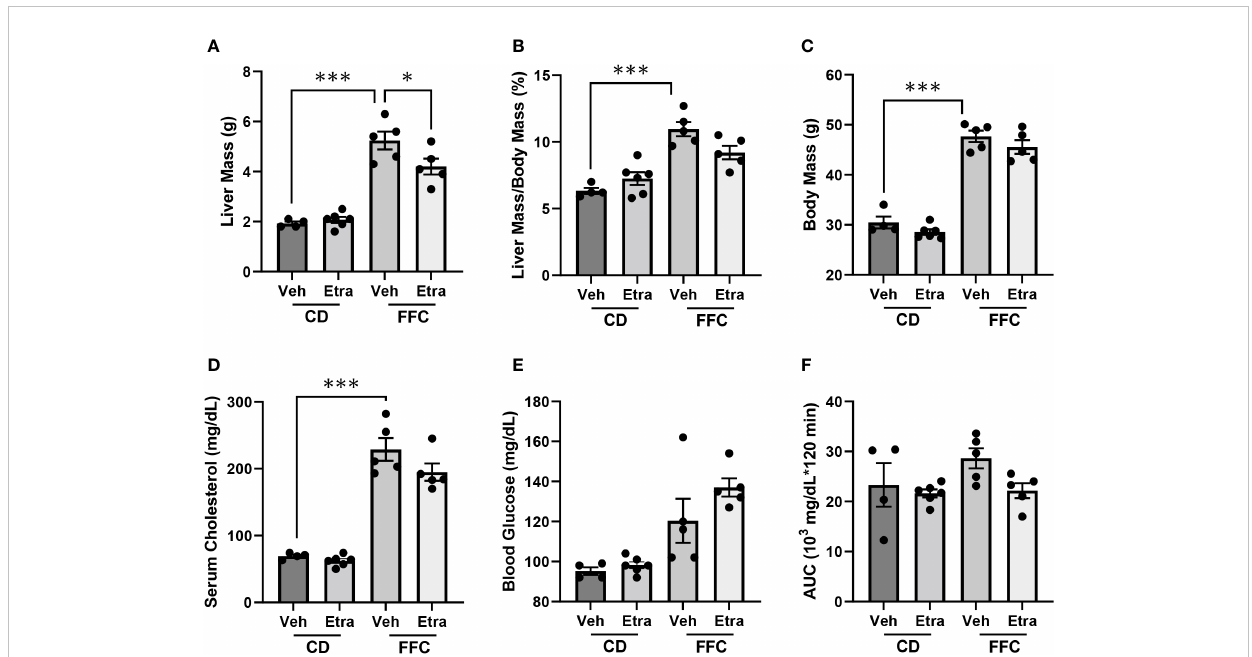
FIGURE 2 Metabolic characterization of CD and FFC-fed mice with Etrasimod treatment. (A) Liver mass, (B) liver to body mass ratio, (C) and body mass of groups treated with vehicle or Etrasimod. (D) Total cholesterol and (E) fasting blood glucose with vehicle or Etrasimod treatment. (F) Area under the curve (AUC) for the glucose tolerance test at 22 weeks on diet and 2 weeks of Etrasimod treatment. CD (n=10) and FFC (n=10). *p<0.05,